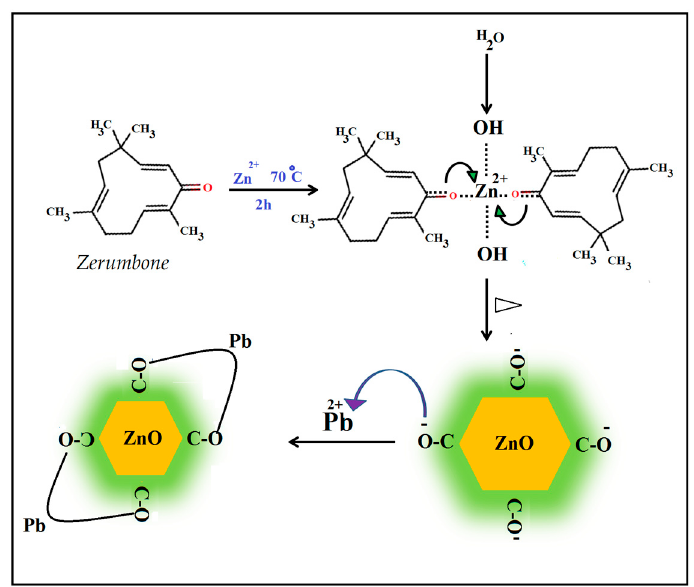
Figure 1. Schematic illustration of the synthesis and functionalization of the zerumbone-stabilized ZnO NPs, and possible chelating of Pb 2+ ions to zerumbone.